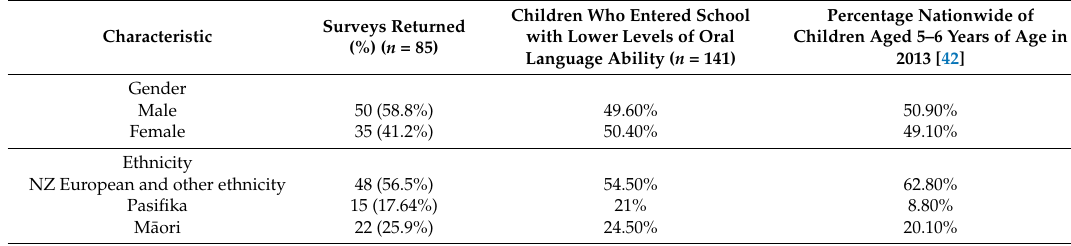
Table 1. Demographic information of the 85 children whose wh ā nau participated in the survey compared with national demographics for children of the same age. NZ—New Zealand.